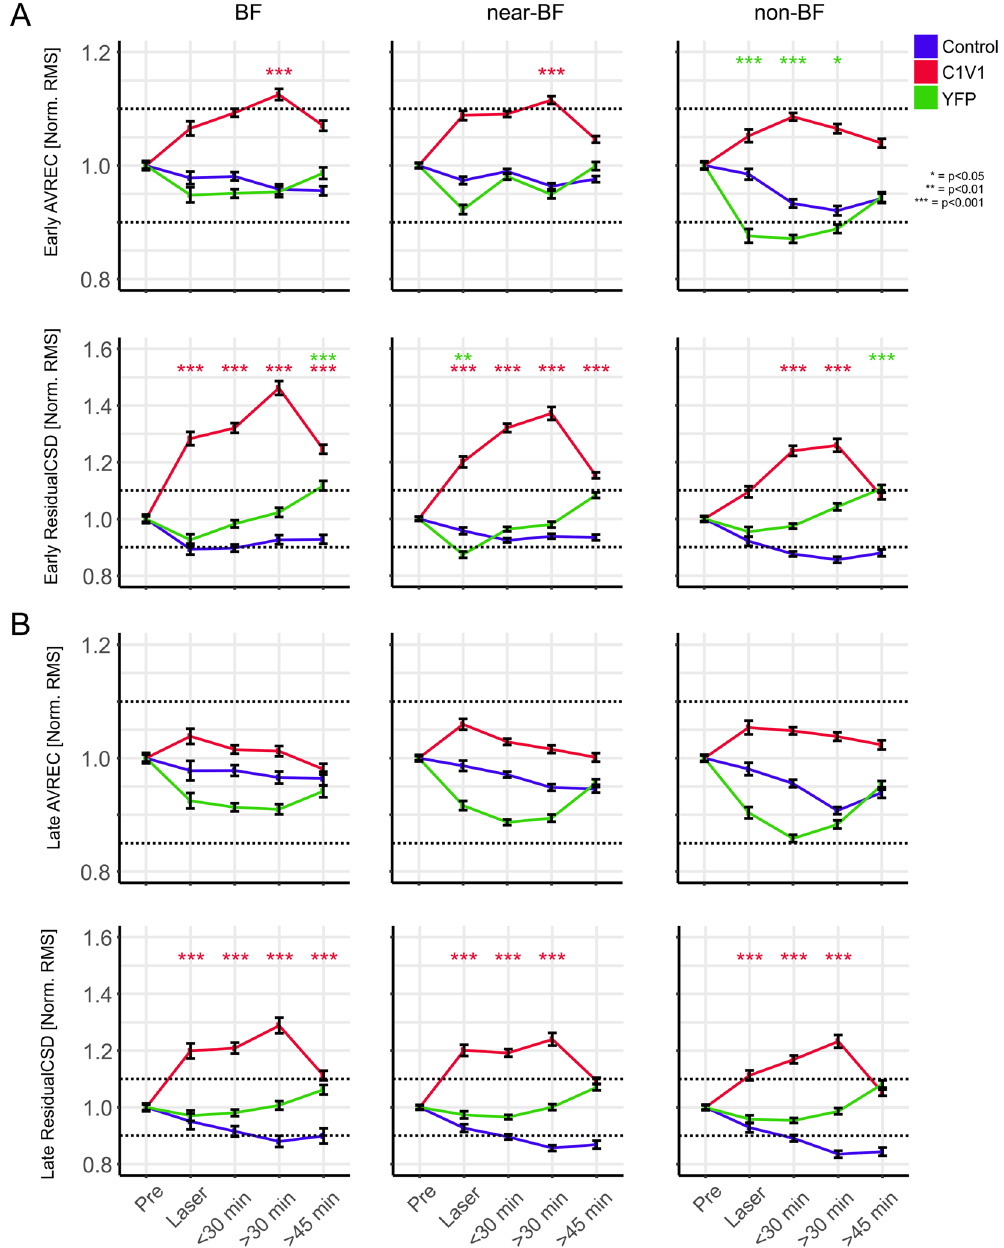
Figure 6. Normalized single-trial early and late AVREC and ResidualCSD RMS values over time. ( A ) Temporal time course of averaged early single-trial RMS AVREC (top) and ResidualCSD (bottom) values normalized to pre-measurements. Data for BF, near-BF and non-BF stimulation is shown separately and was binned for pre- measurements, laser, and post-measurements ( < 30 min, > 30, > 45 min). Note the prominent increase of early RMS AVREC values for the C1V1 group whereas control and YFP group displayed a more stable or decreasing time course, respectively. Also, early RMS ResidualCSD values significantly increased during and after the Laser measurements for BF, near- and non-BF bins of the C1V1 group, whereas YFP and control display a more stable time course. ( B ) Temporal time course of late Pre-normalized RMS AVREC and ResidualCSD values of single- trial data for BF, near-BF and non-BF. Late RMS AVREC values for the C1V1showed a mild, yet not significant, increase that did not surpass the + 10% criterion. The control group displayed a stable and slightly declining time course for the late RMS AVREC values, while the YFP group showed a moderate decrease that recovered over time. Late RMS ResidualCSD values increased during and after the Laser measurements for BF, near- and non-BF bins of the C1V1 group, whereas YFP and control groups both showed a more stable time course. Significances in ( A,B ) were calculated using mixed linear models on the normalized data. Asterisks indicate corresponding significances in comparison to the control group, in case values exceed the ± 10% pre-criterion. Single-trial CSD data in following figure is presented